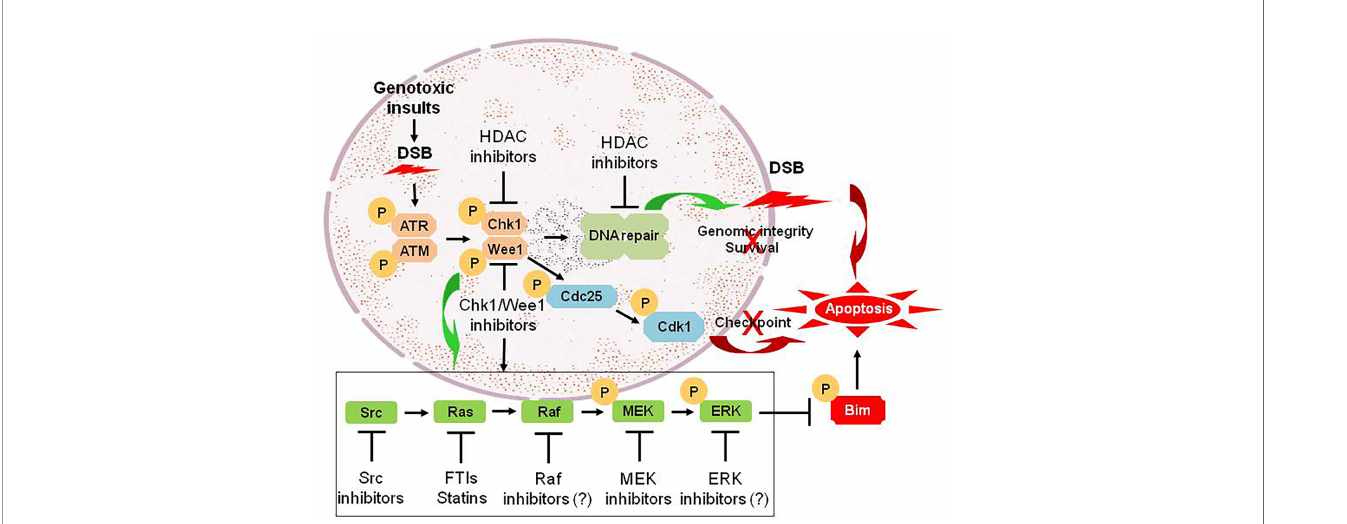
FIGURE 2 | An example for the DTT approach via parallel inhibition. As DNA damage checkpoint and the Ras/Raf/MEK/ERK pathway represent two separate mechanisms for maintaining genomic integrity and survival of tumor cells under intracellular and extracellular stresses (e.g., genotoxic insults caused by conventional DNA-damaging chemotherapeutics).Treatment with Chk1(or Wee1) inhibitorspromotes DNA damage by abrogating checkpoints via Cdc25-mediated dephosphorylation of Cdk1 at inhibitory sites, an effect that could bepotentiatedby HDAC inhibitors via down-regulation of multiplegenes involving DNA damagecheckpoint and repair (linear inhibition). However,they also triggersactivation of the Ras/Raf/MEK/ERK pathway via a not-yet-de fi ned crosstalkbetween these two pathways, which most likely accounts for non-geneticresistance to Chk1 (or Wee1) inhibitors. Thus, a DTT approach via parallel inhibition of both DNA damage checkpoint (pathway #1)and its complementary Ras/Raf/MEK/ERK signalingcascade(pathway #2; e.g., byinhibitors of Src, Ras, Raf, MEK, andERK, which act to prevent phosphorylation and degradation of pro- apoptoticproteins such as Bim, thus priming tumor cellsfor death induced bytargeted agents likeChk1/Wee1 inhibitors), leadsto un fi xable DNA damage and thus triggers robust apoptosis. DSB, double-stranded break;P,